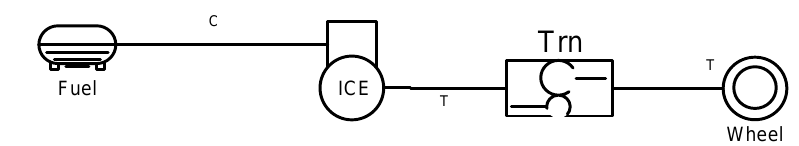
Figure 5. Schematic of a conventional internal combustion engine (ICE) powertrain with transmission [24].